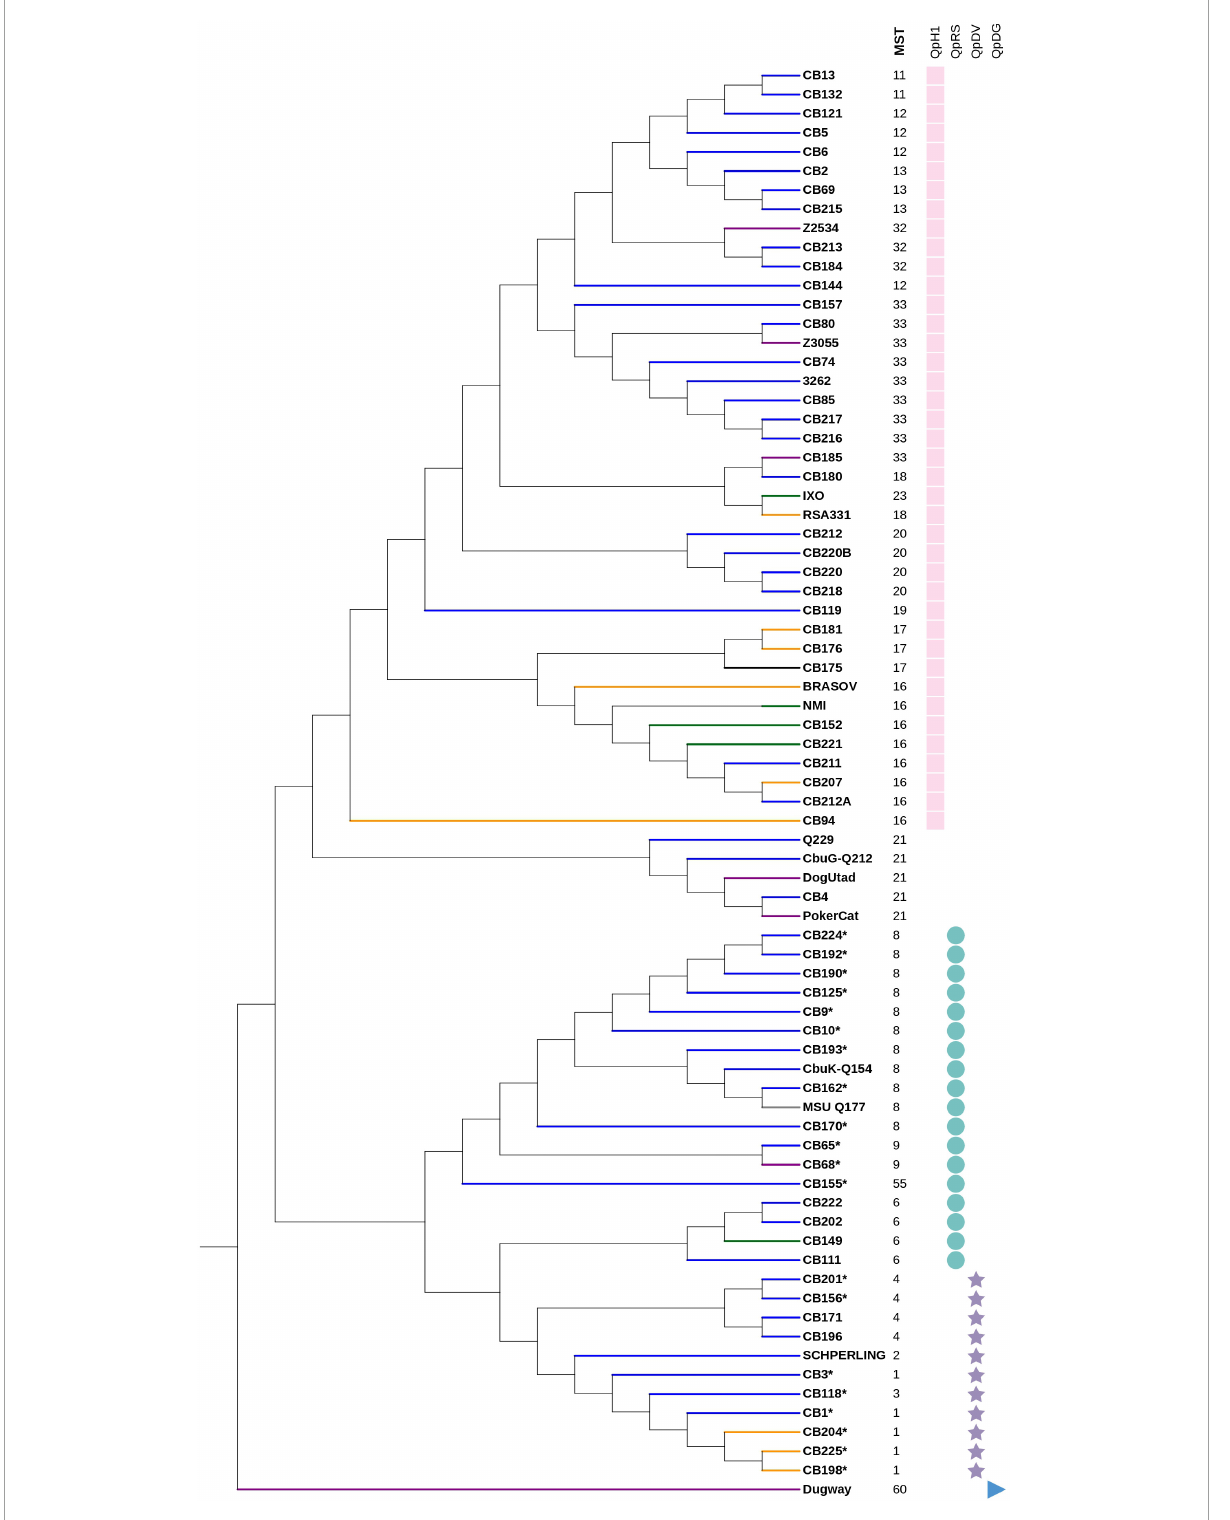
FIGURE1 Phylogenetic tree of 75 Coxiella burnetii strains using core genome regions, using the Maximum Likelihood method within MEGA6. Branch color indicates the associated disease. Blue branch: persistent focalized Q fever, yellow branch: acute Q fever, green branch: tick isolate, purple branch: animal isolate, black branch: others, gray branch: no data available. *: presence of an efflux pump. On the right panel: the first column represents the MST genotype, the remaining columns represent the presence of plasmids with each symbol indicating a plasmid